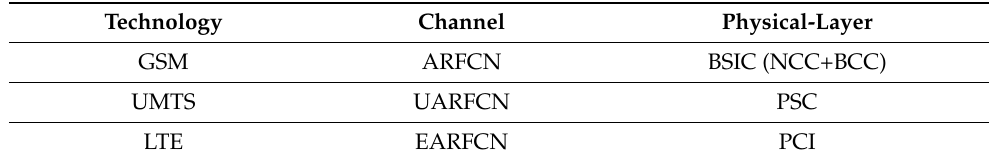
Table A2. Physical-layer cell